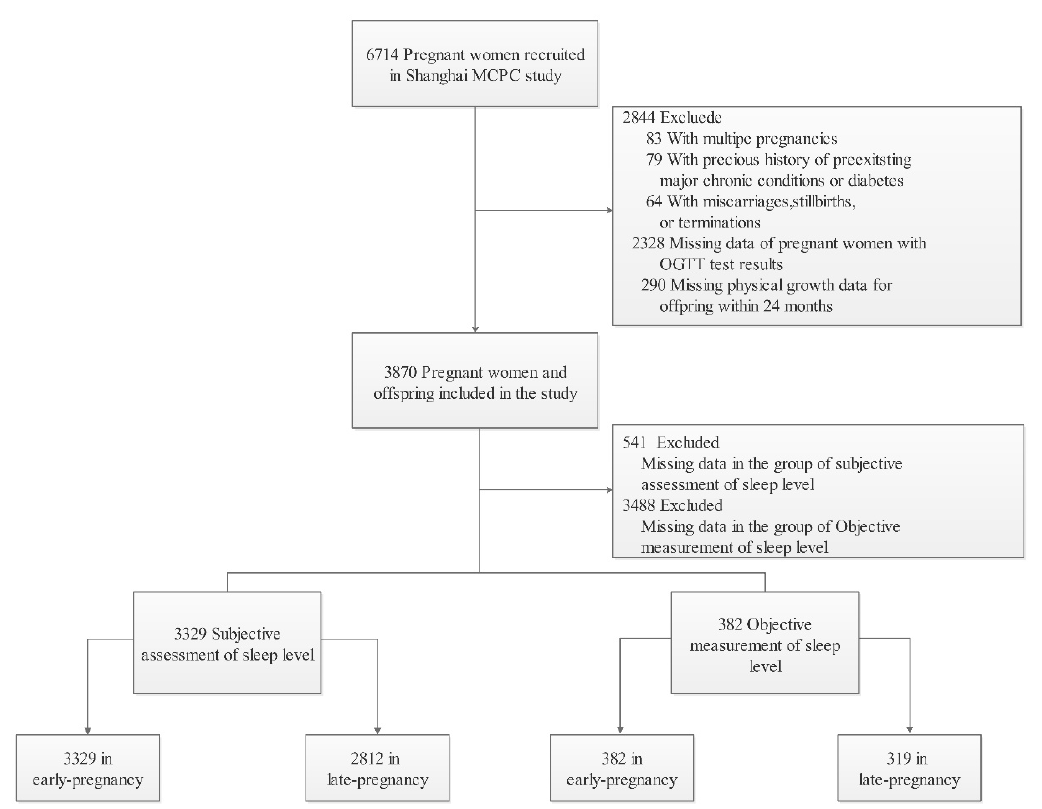
Figure 1 details the participant selection process.